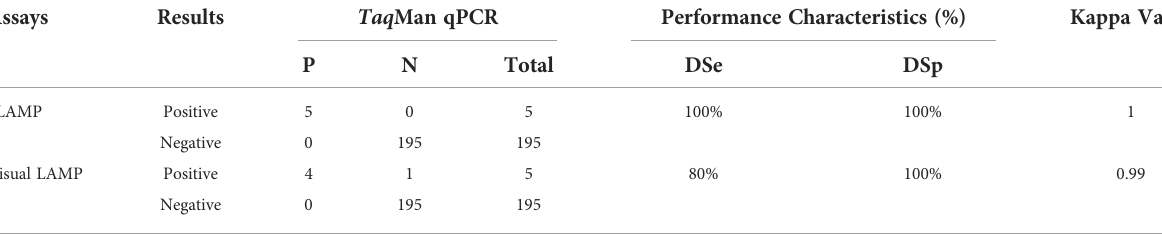
TABLE 4 Comparison of the tests for T. gondii positive standard plasmid DNA by qLAMP, visual LAMP and Taq Man qPCR. Assays Results Taq Man